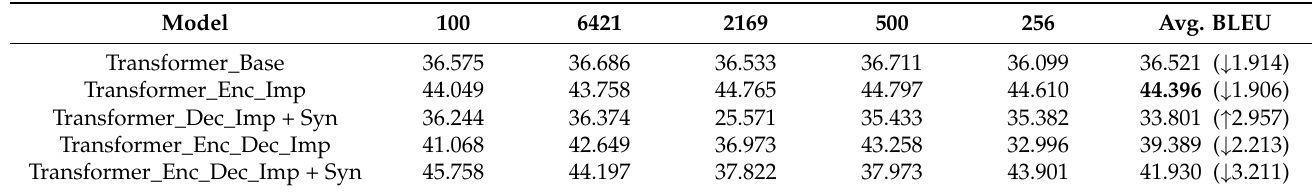
Table 5. BLEU evaluation of five-layer models on different random